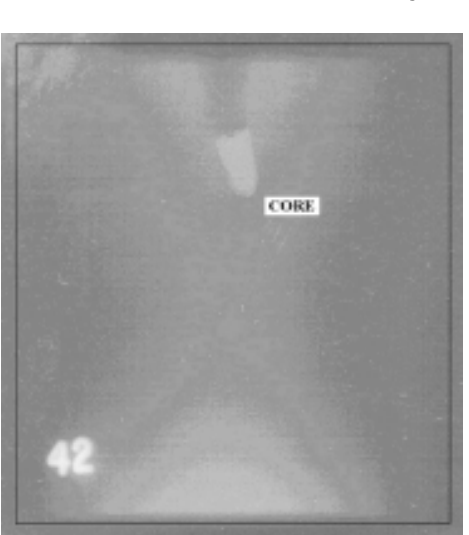
Fig. 4. Depth of penetration testing.